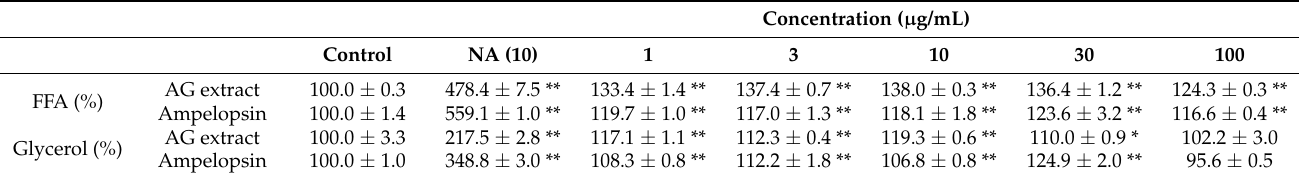
Table 4. Lipolytic effects of AG extract and ampelopsin on the rat epididymal fat pad.